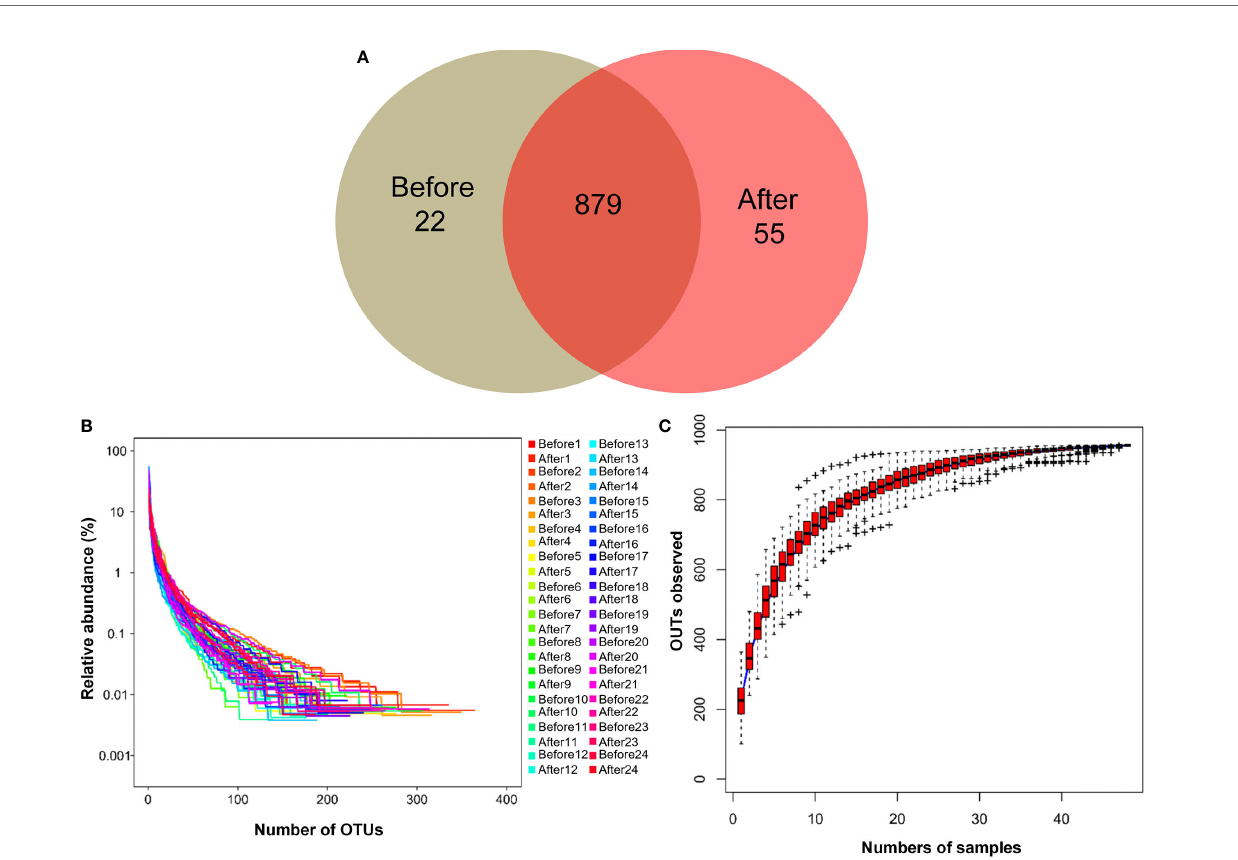
FIGURE 1 | Characteristics of two microbiota. (A) Venn diagram. The Venn diagram shows the unique operational taxonomic units (OTUs) pre-intervention (Before; brown) and post-intervention (After; light-red), and the number of shared OTUs (dark-red) pre- and post-intervention. (B) OTU rank abundance curves. The legend indicates the Sample Number. Before presents pre-intervention. After presents post-intervention. (C) Species accumulation boxplot of the 48